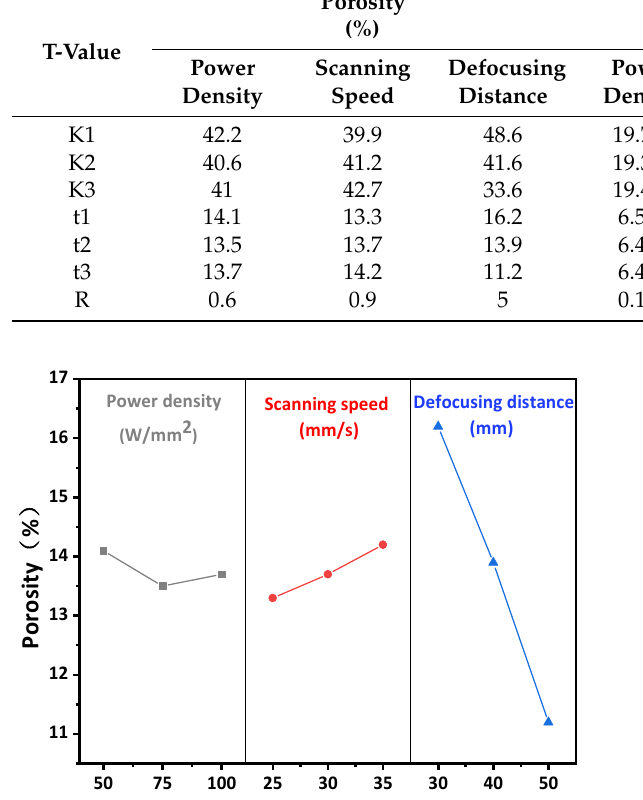
Figure 2. Effect of laser micromelting parameters on porosity of Y 2 O 3 coating.